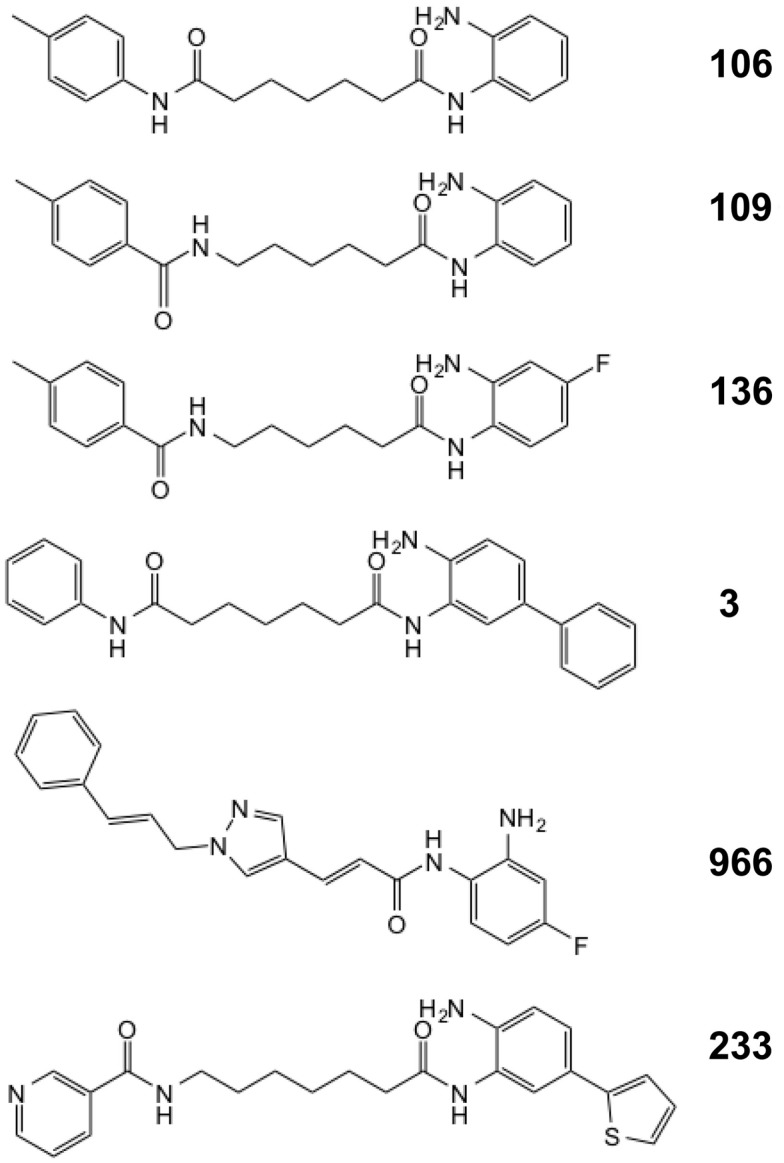
Structures of the HDAC inhibitors.